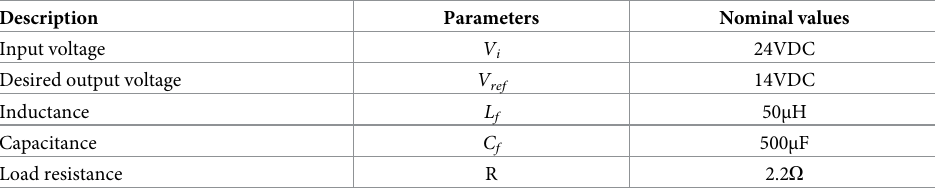
Table 1. Simulation parameters of Full-Bridge converter.